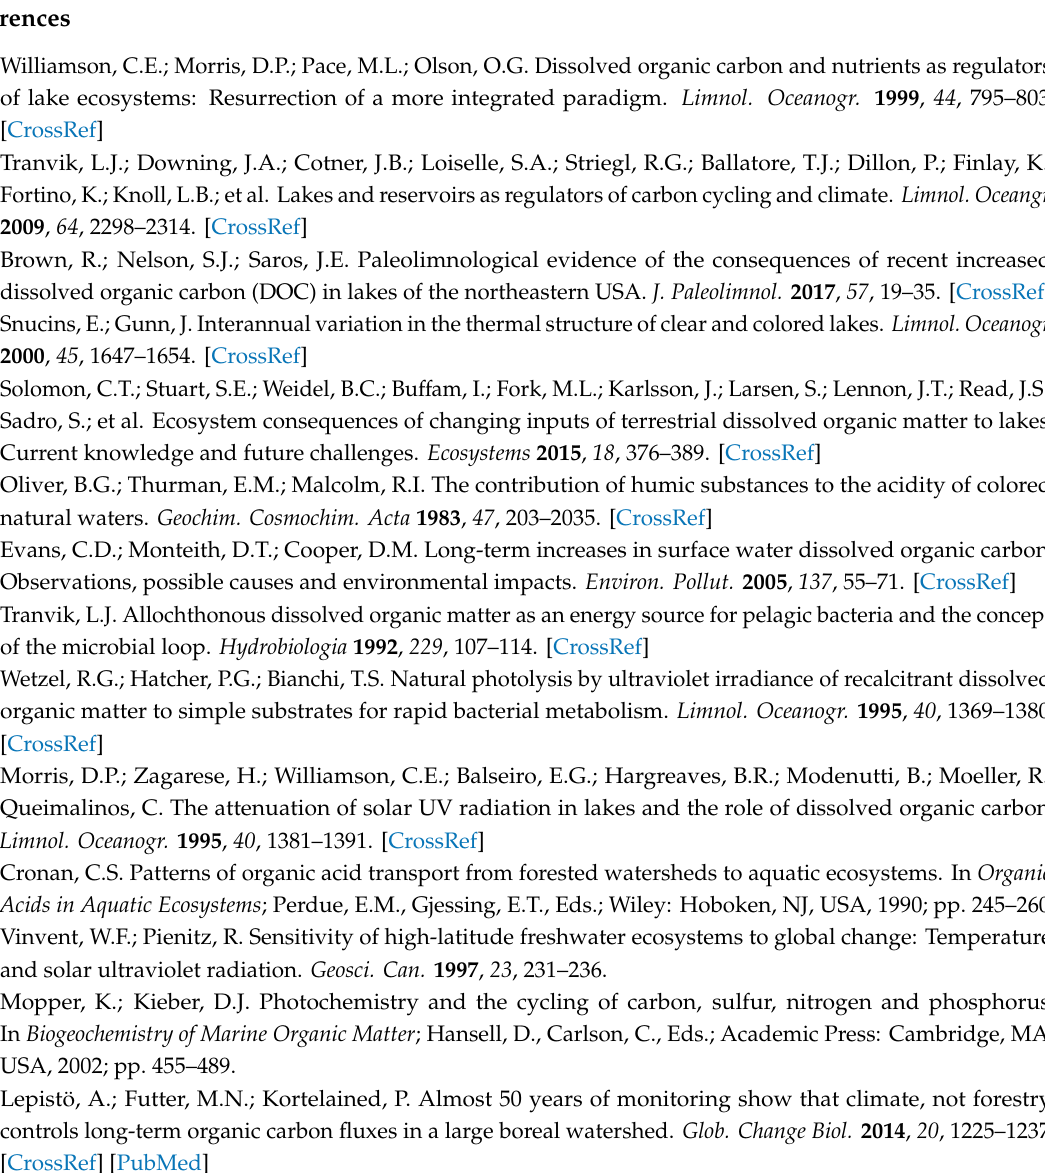
Table S1: Initial pre-storm values and percent change for P1 and P2 samplings, Figure S1: Percent change for each lake in response to the Early Summer storm and the Autumn